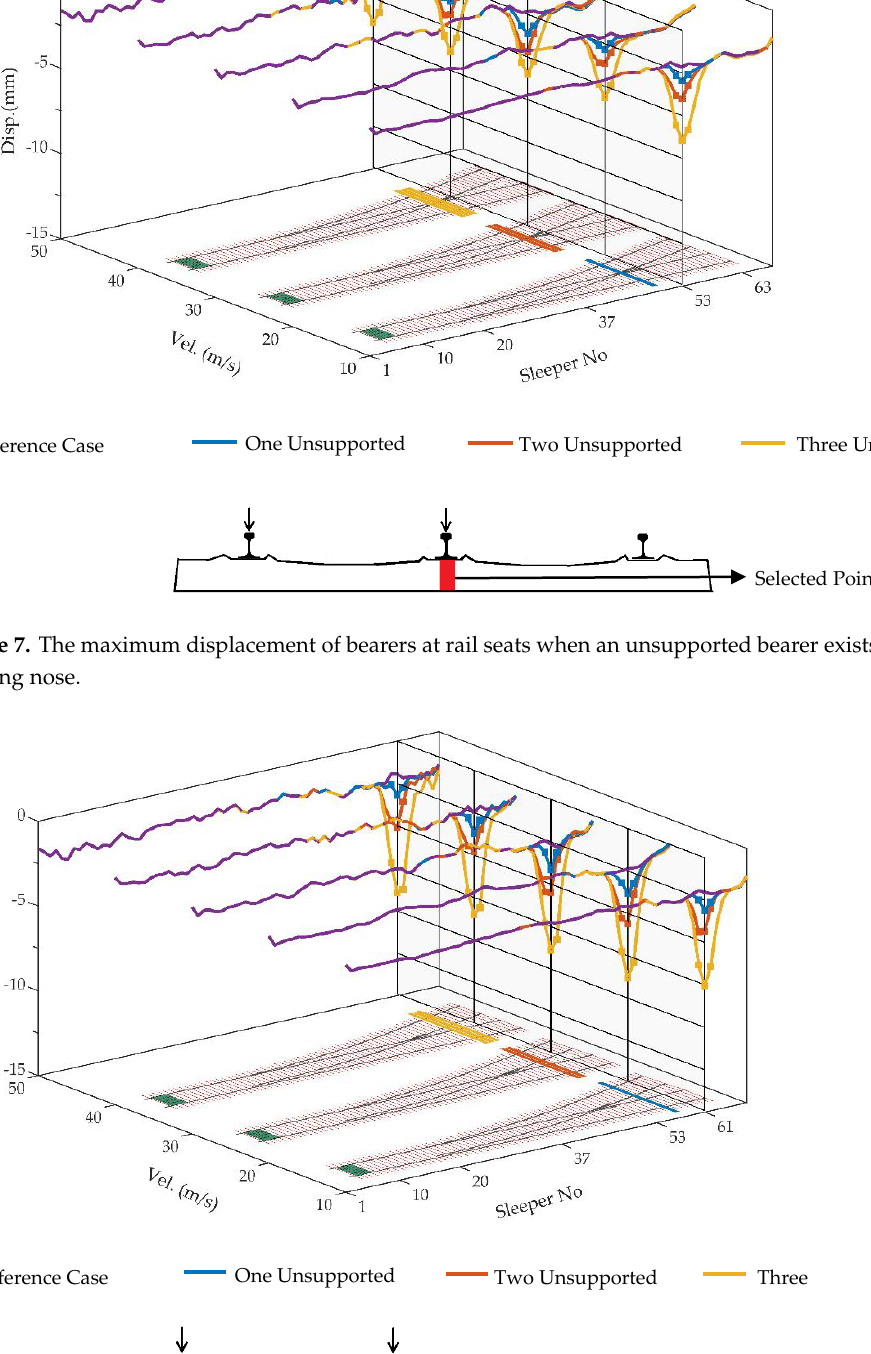
Figure 8. The maximum displacement of bearers at rail seats when the longest bearer is unsupported.